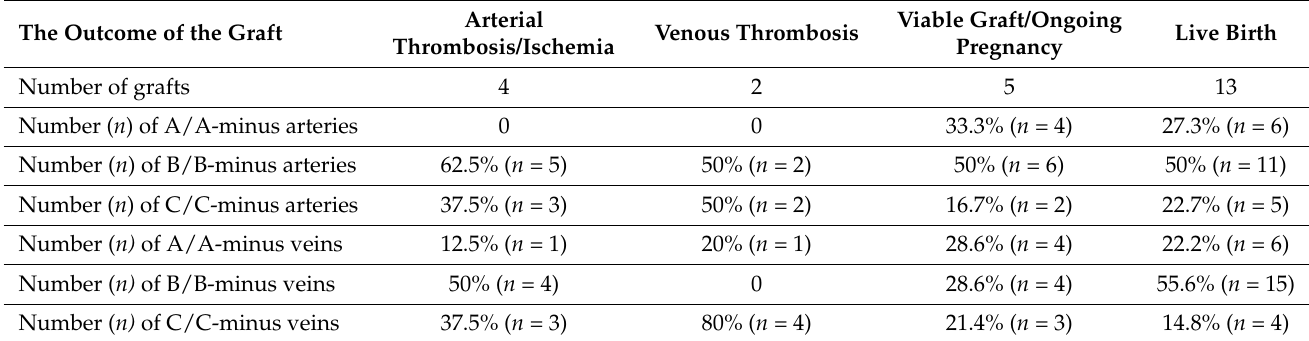
Table 4. The outcome and the caliber of uterine